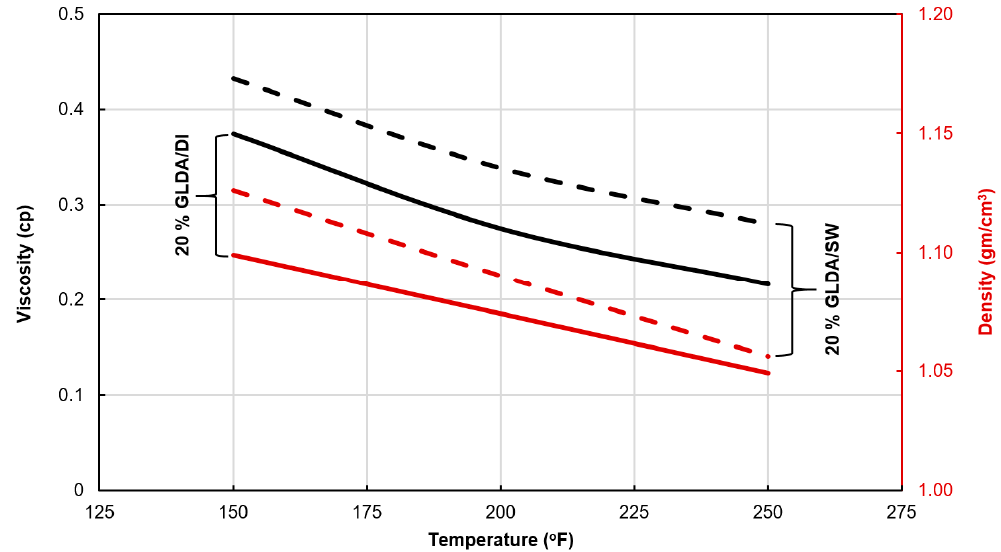
Figure 5. Density and viscosity of 20 wt% GLDA (3.8 pH) prepared in seawater and DI water as a function of temperature.